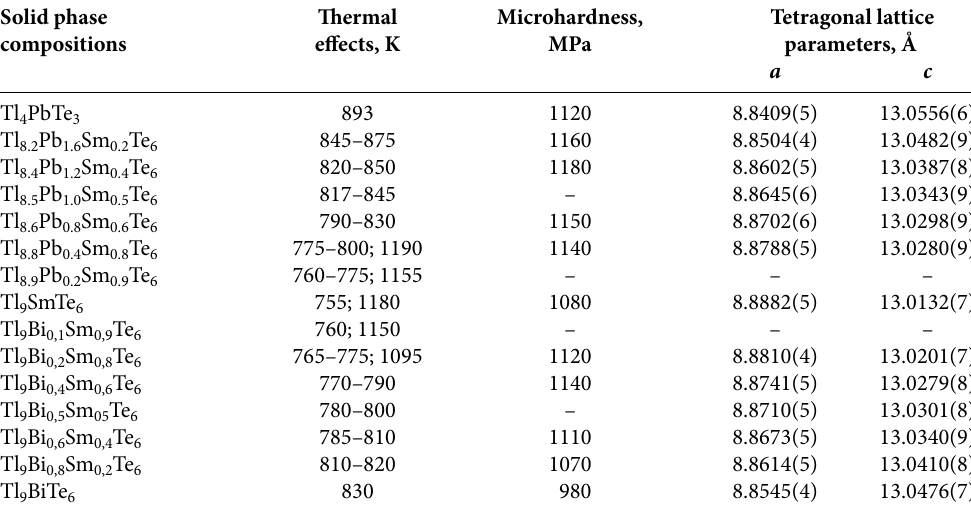
Table 1. Experimental data of the DTA, microhardness measurements and parameters of tetragonal lattice for the al- loys of the Tl 4 PbTe 3 -Tl 9 SmTe 6 and Tl 9 BiTe 6 -Tl 9 SmTe 6 sections of the Tl-Pb-Bi-Sm-Te system Solid phase Thermal Microhardness, Tetragonal lattice compositions effects, K